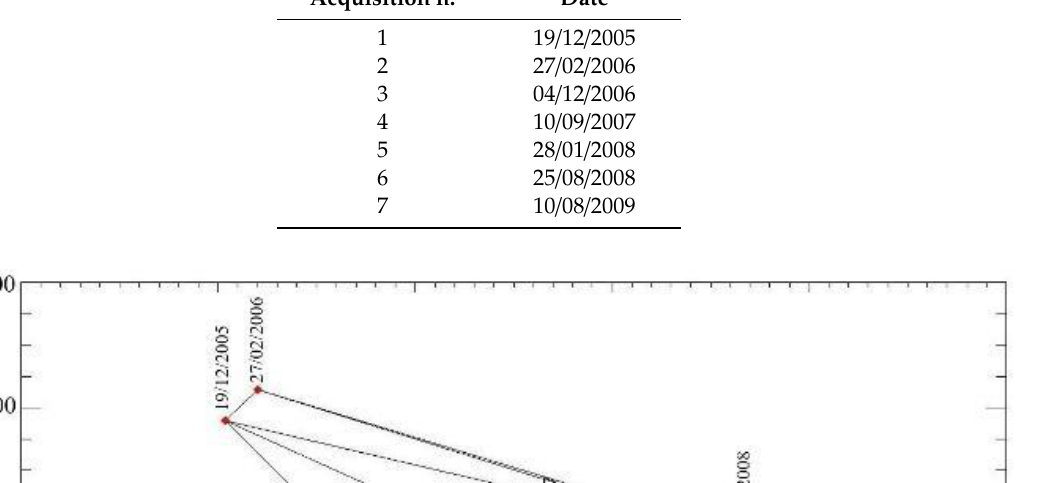
Table 4. Envisat / ASAR acquisition data of the Afar depression zone. Date format is day / month / year. Acquisition n.